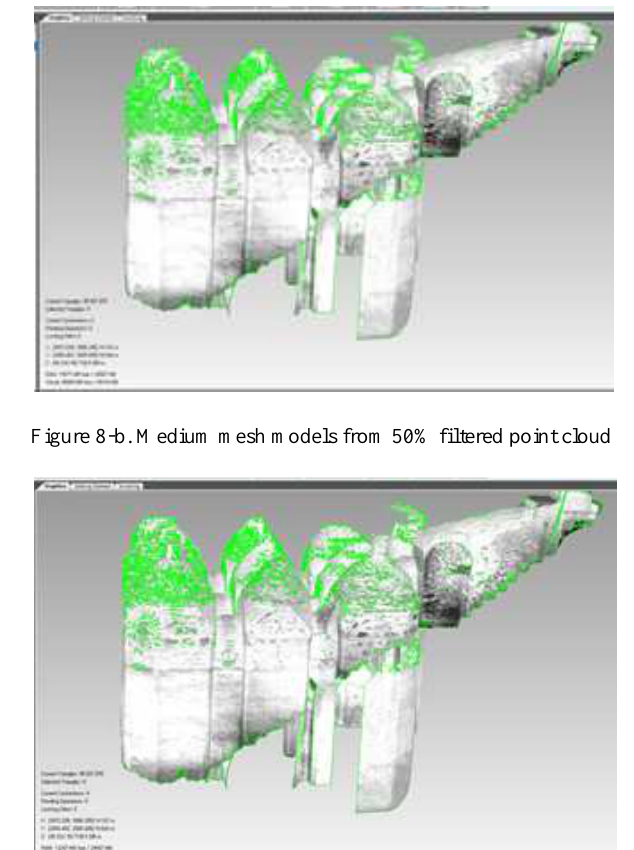
Figure 8-c. Medium mesh models from 75% filtered point cloud Due to complexity and type of material of the Sarnicli Han , some holes appeared after scanning. The holes have been filled and evaluated for each filtering and related mesh smoothing level. In the presented study, the holes have been filled for meshes which have been created from 25%, 50% and 75% filtered point cloud data and smoothed minimum, medium and maximum. For hole filling, linear and curvative methods have been used. The curvative hole filling results for 25% filtered point cloud and medium smoothed mesh, 50% filtered point cloud and medium smoothed mesh and 75% filtered point cloud and maximum smoothed mesh have been presented in Figure 9- a,b,c.